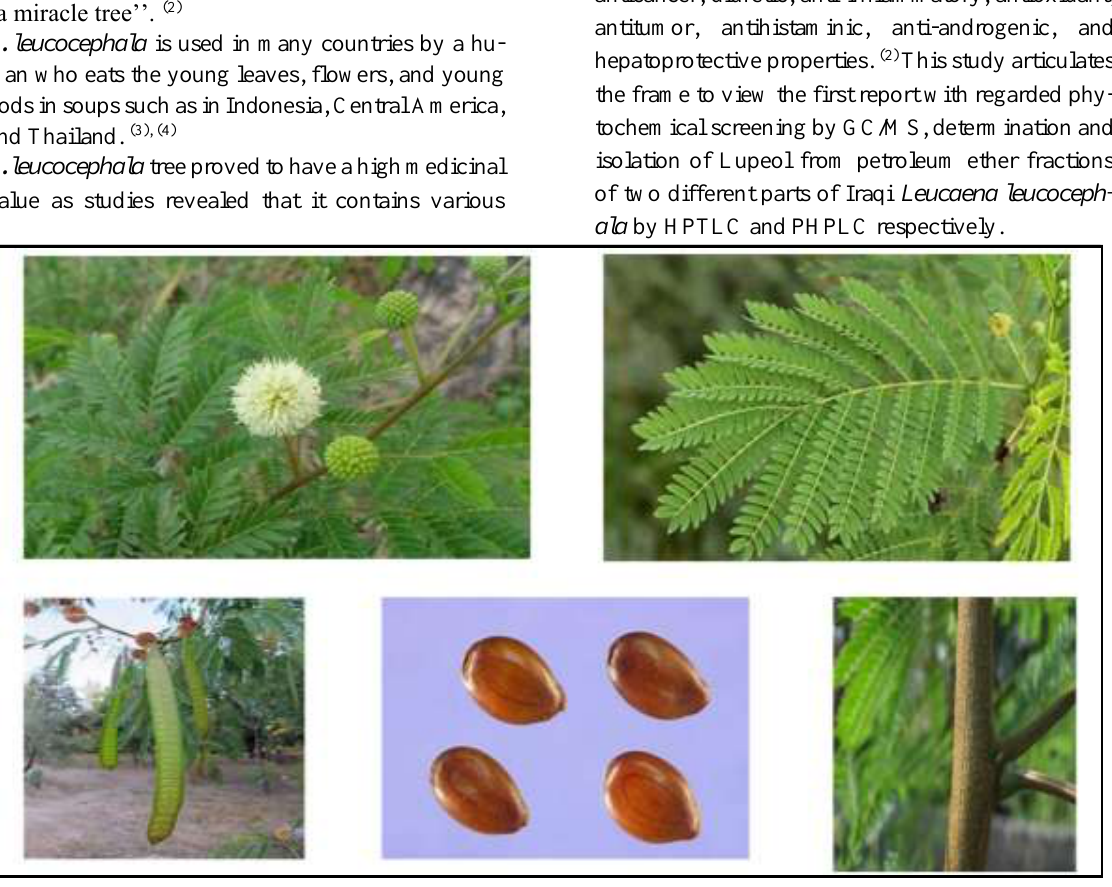
Figure1. Photos of flowers, leaves, fruits, seeds, and stems of the Iraqi Leucaena leucocephala plant (27)